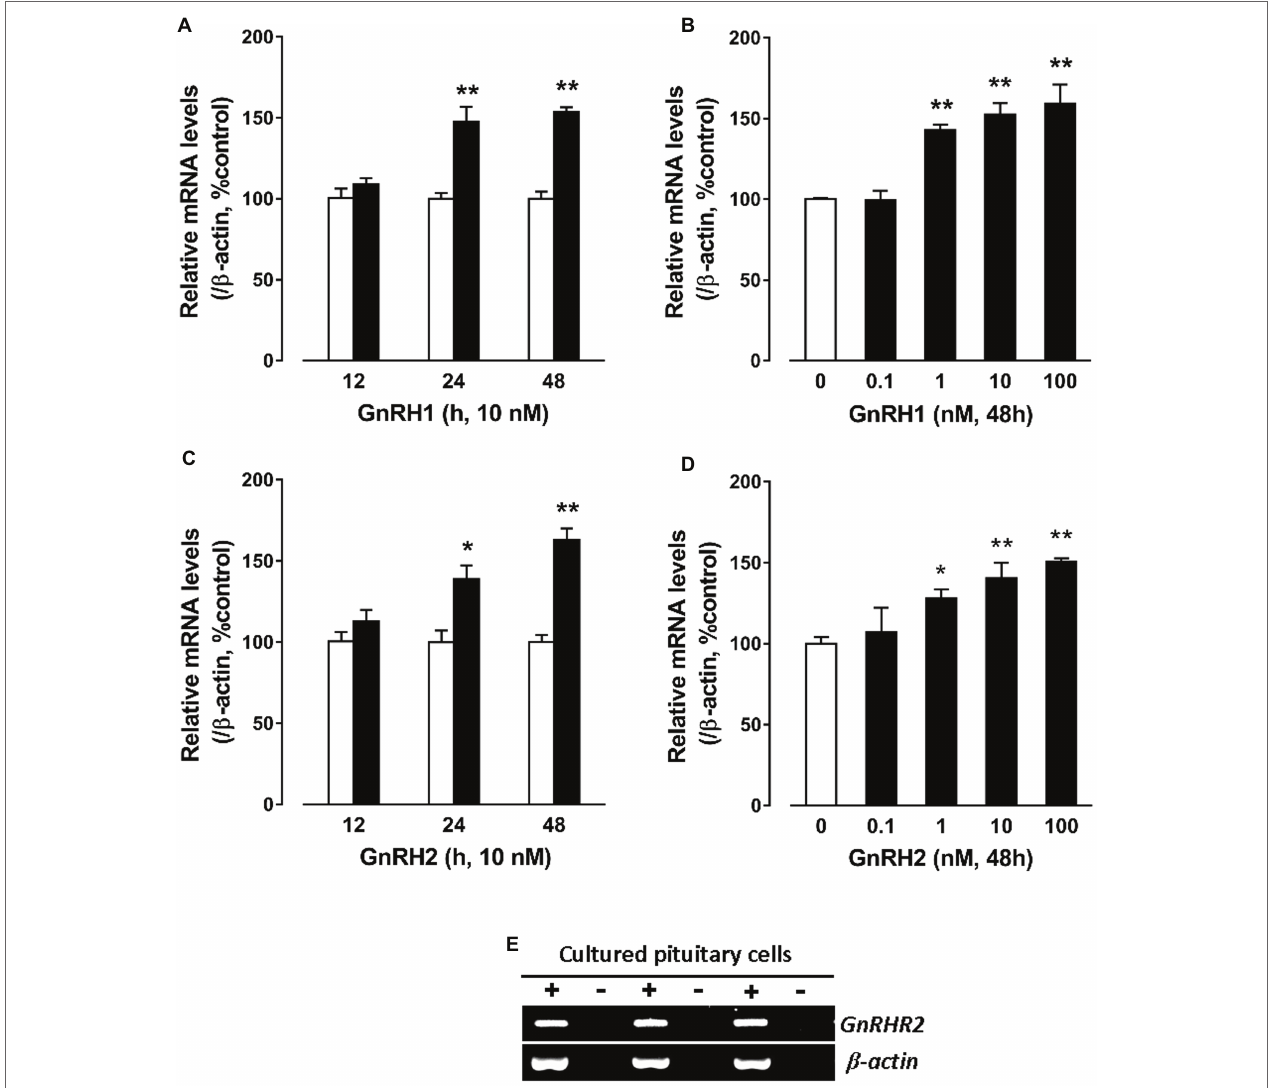
FIGURE 4 | Quantitative real-time PCR (qPCR) assay showing the effects of gonadotropin-releasing hormone (GnRH) on cocaine- and amphetamine-regulated transcript ( CART ) expression in cultured chick pituitary cells. (A,C) Time- and (B,D) dose-dependent effects of chicken GnRH1 and GnRH2 on CART mRNA expression in cultured chick pituitary cells. Pituitary cells were incubated with GnRH1 (10 nM) or GnRH2 (10 nM) for the duration as indicated or with increasing doses (0–100 nM, 48 h) of GnRH1 or GnRH2 and subjected to qPCR assay of CART expression. The mRNA levels of CART were normalized by β -actin and expressed as the percentage of respective controls. Each value represents the mean ± SEM of four replicates ( N = 4). * p < 0.05, ** p < 0.01 vs. respective control. (E) RT-PCR detection of GnRHR2 expression in cultured chick pituitary cells (three replicates). RT was performed in the presence (+) or absence (−) of reverse transcriptase. Parallel PCR of β -actin was performed to serve as an internal